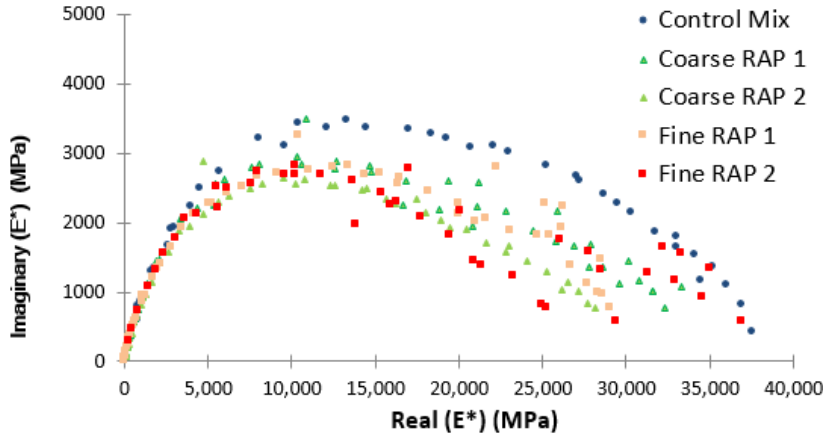
Figure 20. Complex modulus master curve in Cole-Cole plot.